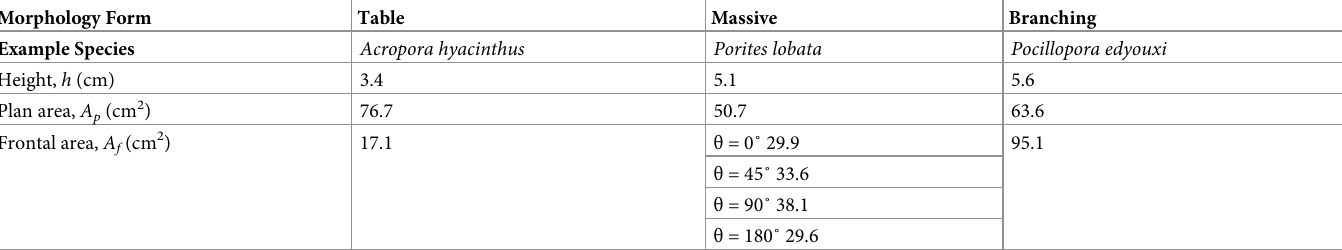
Table 2. Geometry of each archetypal coral colony morphology used in the numerical models and experimental validation. Morphology